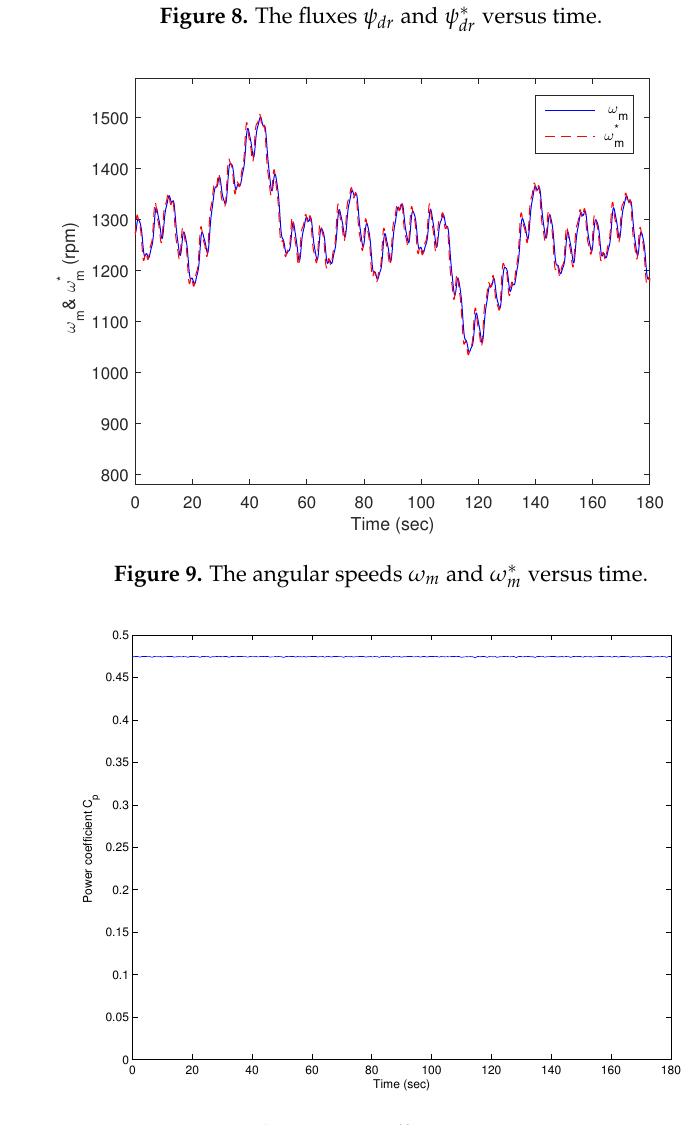
Figure 10. The power coefficient C p versus